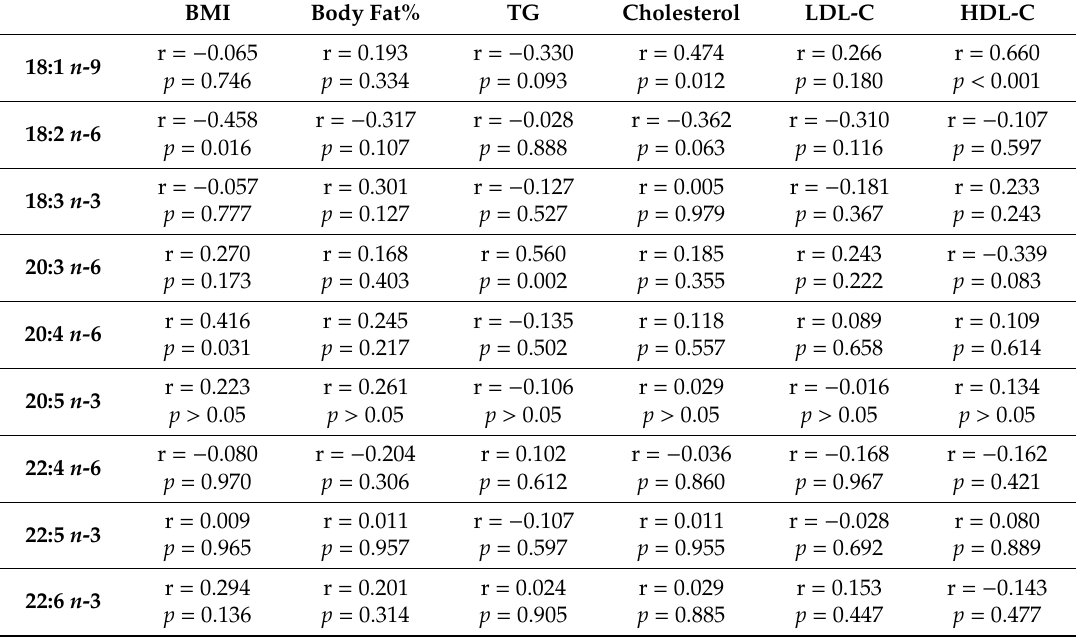
Table 4. Correlations between individual plasma fatty acids with anthropometrical and biochemical parameters in study subjects.